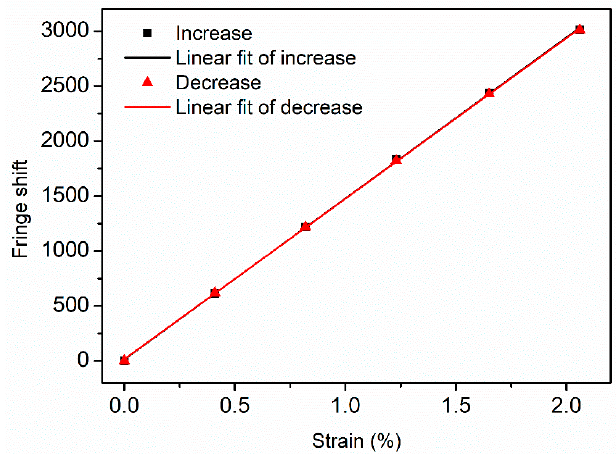
Figure 9. Fringe shift versus axial strain (increase and decrease) for non-annealed PC mPOF with linear response.